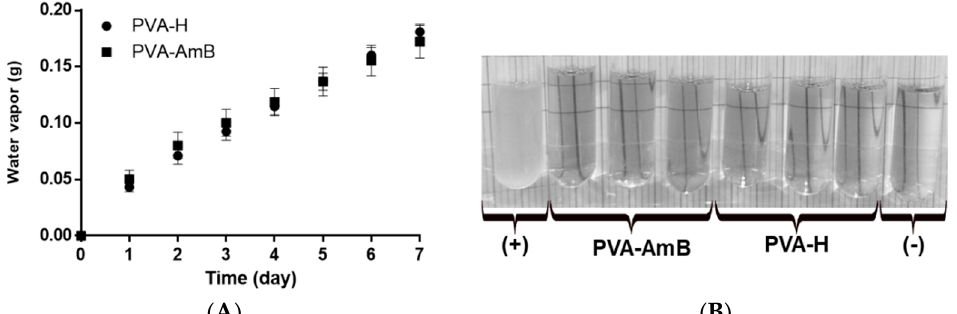
Figure 4. ( A ) Water vapor transmission rate of PVA–H and PVA–AmB hydrogels. ( B ) Medium aspect of positive (+) and negative ( − ) controls, as well as PVA–H and PVA–AmB after 7 days exposure to the environment, showing the resistance of the hydrogels to microbial permeability.